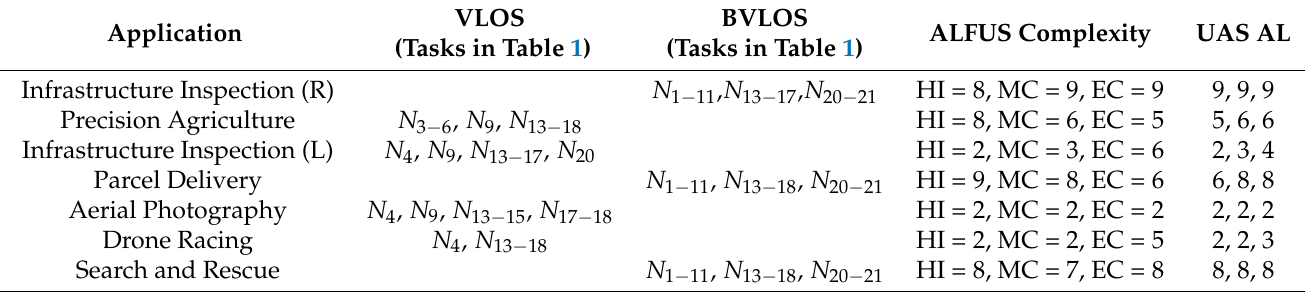
Table 2. Relationship between type of application and number of suggested onboard tasks. In this table, Infrastructure Inspection is divided into remote (R) and local (L). UAS autonomy level (AL) shown is the mode, median, mean (arithmetic), respectively (see Figure